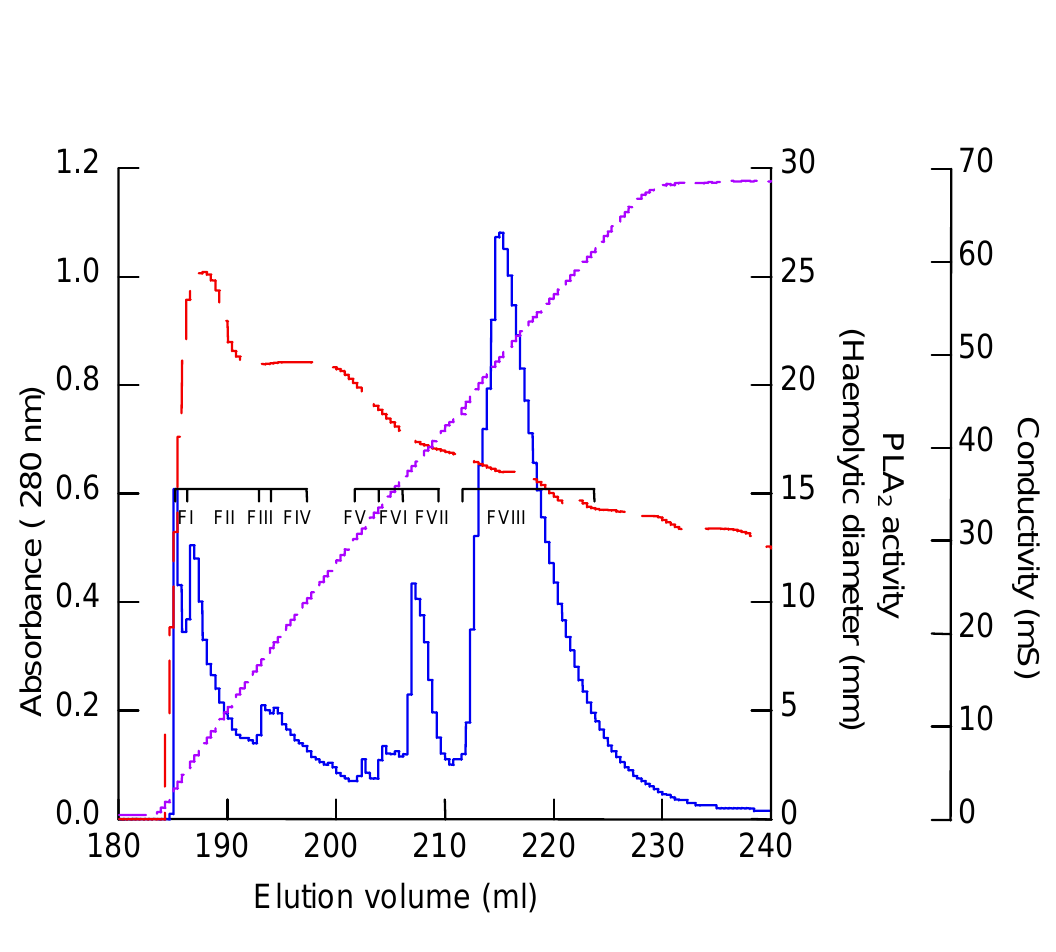
Figure 2. Cation-exchange chromatography on mono S of the fraction 3 from Sephadex G-75. 8.5 mg of protein of the fraction 3 (F3) from Sephadex G-75 were applied to the Mono S column (HR 5/5) equilibrated with 10 mM of acetic acid, pH 5, at 60 ml/h and collection fractions of 1 ml. The absorbance was monitored at 280 nm ( ); the elution was carried out in a linear gradient of NaCl concentration from 0 to 1 M, and measured by a conductivity activity was assayed by indirect haemolysis ( ), using egg yolk in monitor ( ), PLA 2 saline solution